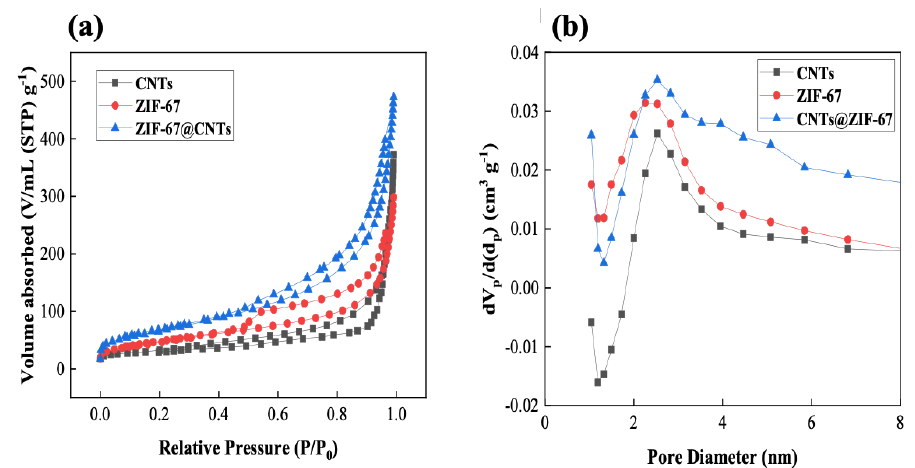
Figure 6. ( a ) Nitrogen absorption / desorption isotherms and ( b ) pore size distributions of the various synthesized materials in this study. Table 1. Specific surface areas and pore volumes of pristine CNTs, ZIF-67, and ZIF-67@CNTs. Samples